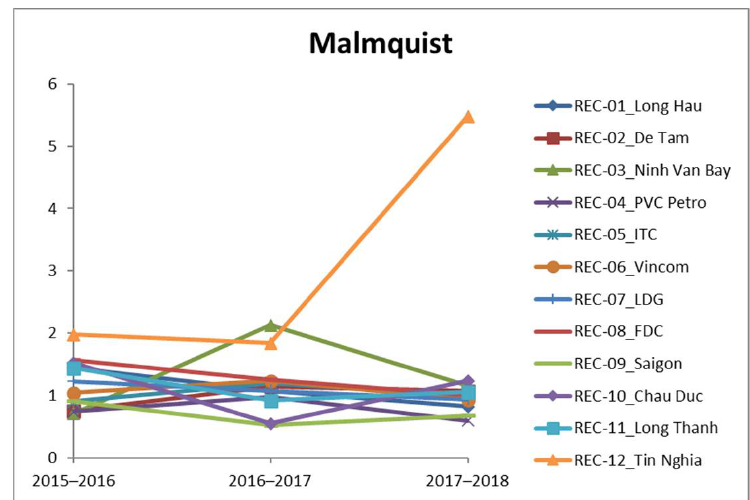
Figure 4. Total factor productivity change